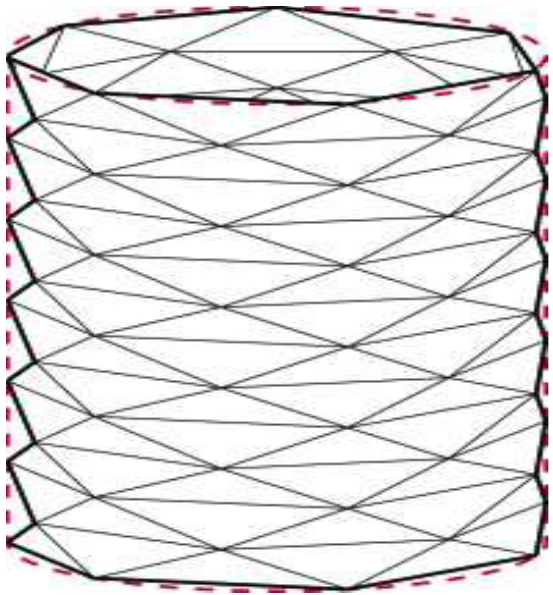
Figure 1. Schwartz